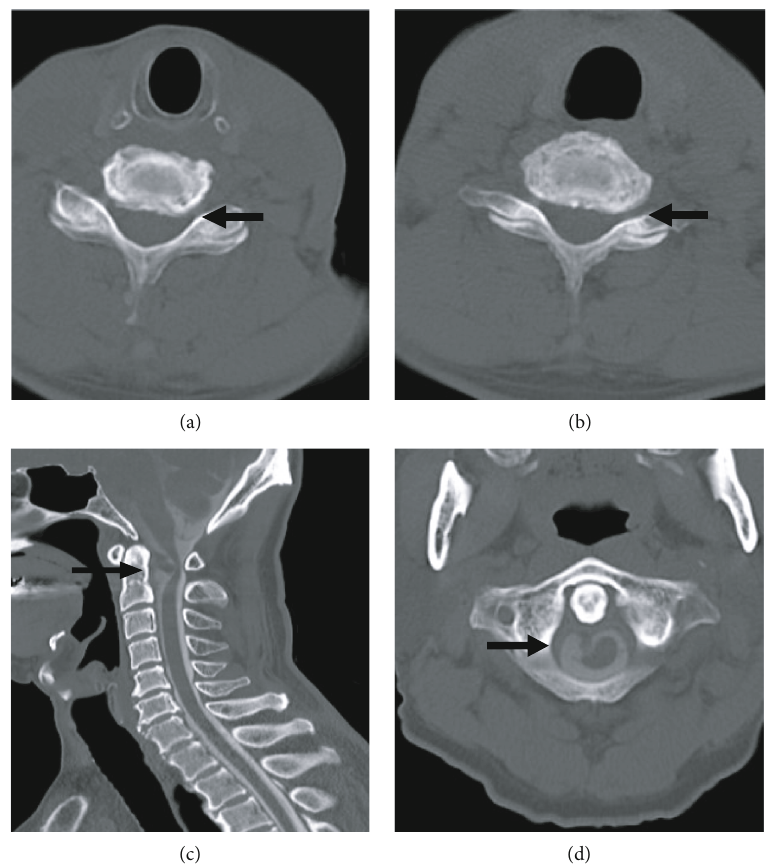
Figure 4: Noncontrast-enhanced computed tomography (CT) and CT myelography. Foraminal stenosis of the left C6-7 intervertebral foramen was identi fi ed in the horizontal section ((a, b), arrow). CT myelography showed an intradural extramedullary cyst ((c) sagittal; (d) horizontal, arrow).